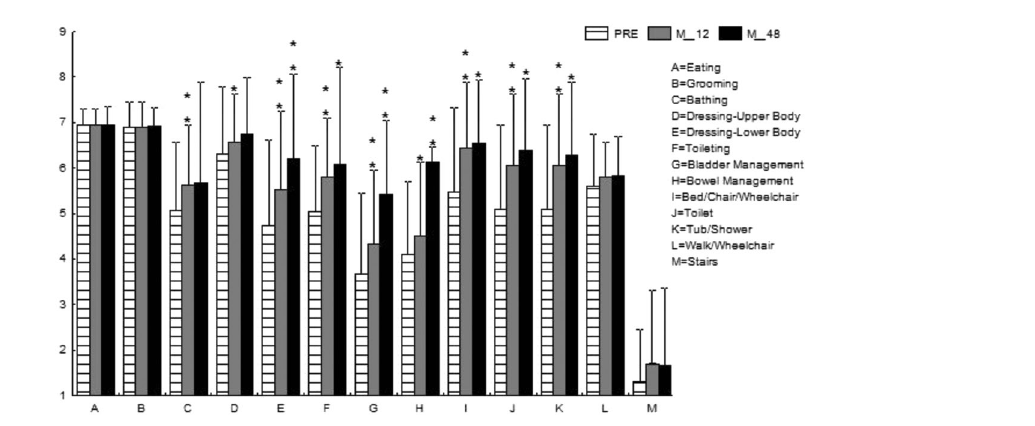
Figure 7. Mean Functional Independence Measure in the cervical group. * p < 0.05; ** p < 0.001.